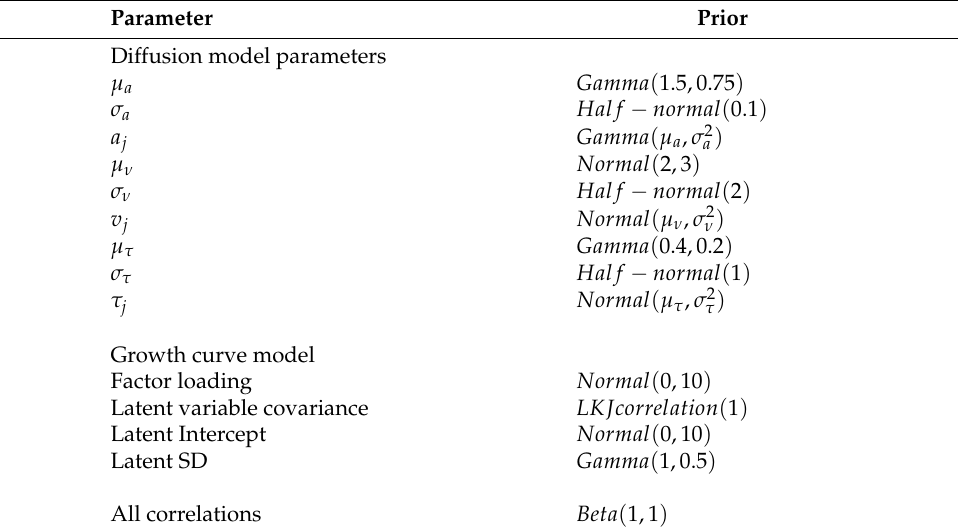
Table A1. Prior distributions used in all